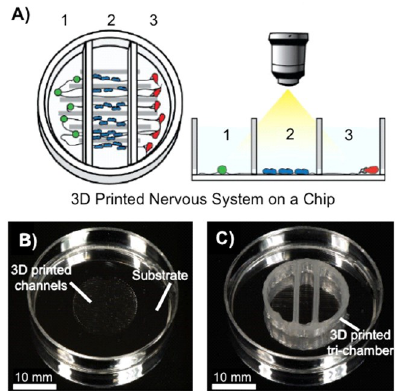
Figure 5. ( A ) Scheme of a representative 3DNSC for peripheral nervous system applications, showing (1) PNS neurons in chamber 1, (2) Schwann cells in chamber 2, and (3) terminal cell junctions in chamber 3. The Schwann cells and the terminal cells interact with the neurons and each other solely via the axonal network. ( B ) Circular pattern of 3D printed silicone microchannels for axonal guidance in the center of a plastic 35 mm dish. ( C ) A 3DNSC showing perpendicular assembly of microchannel and tri-chamber components. Adapted with permission from ref. [34]. Copyright 2016, The Royal Society of Chemistry.